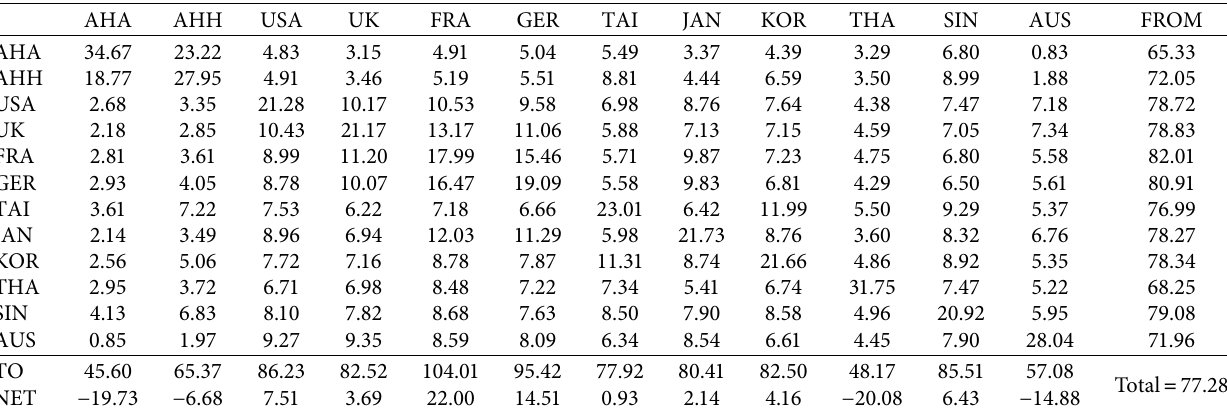
Table 4: Postperiod sample return spillover